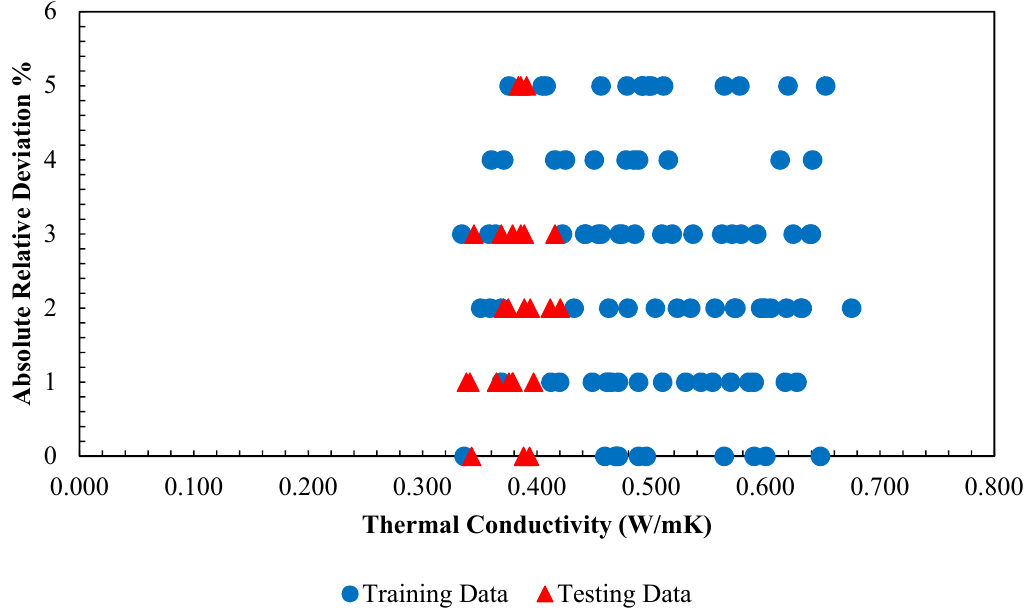
Figure 17. Absolute relative error distribution of the obtained outputs from LSSVM model versus corresponding thermal conductivity of Fe 2 O 3 /ethylene glycol-water nanofluid data points.